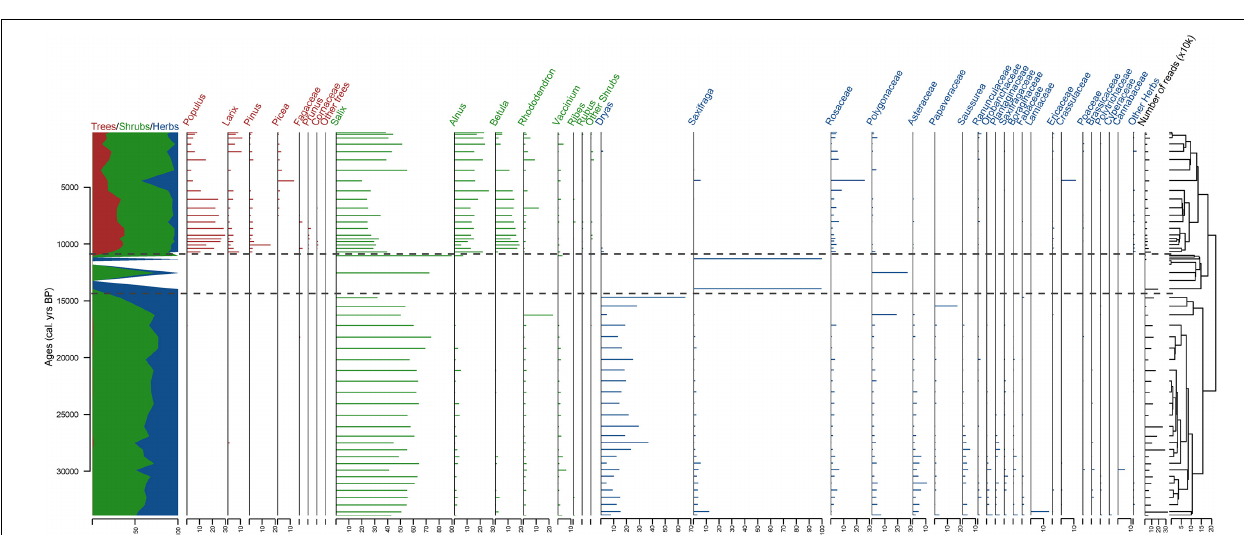
( < 0.001%) in 4 controls, and 1 read for Asteraceae and